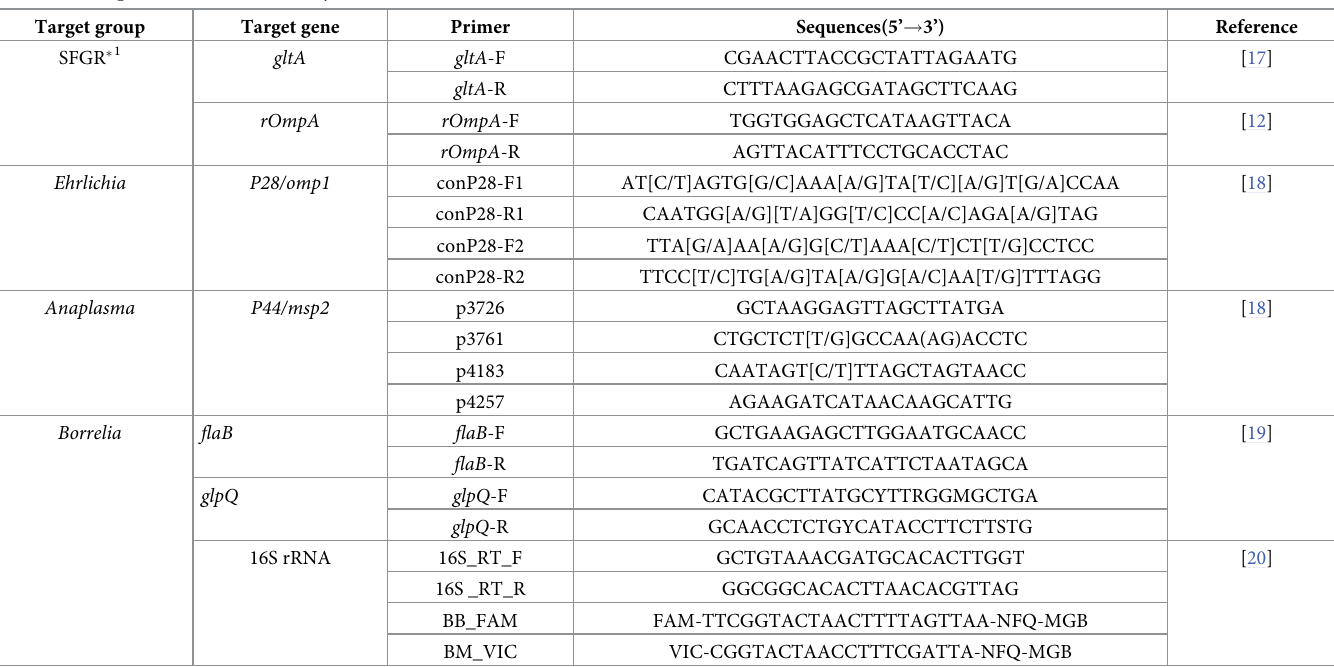
Table 1. DNA primers used in this